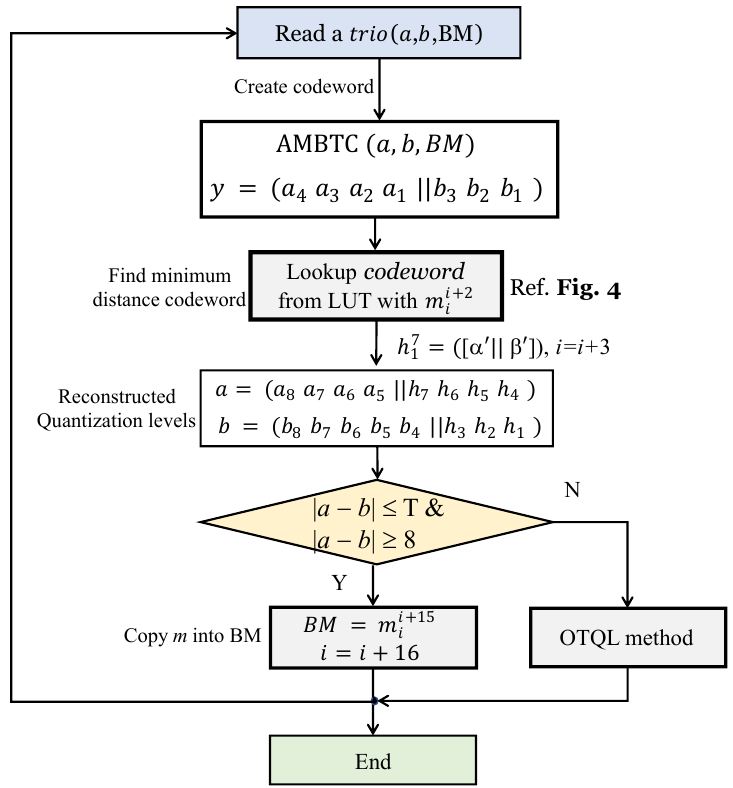
Figure 2. The flowchart of the data embedding process. OTQL, Order of Two Quantization Level.